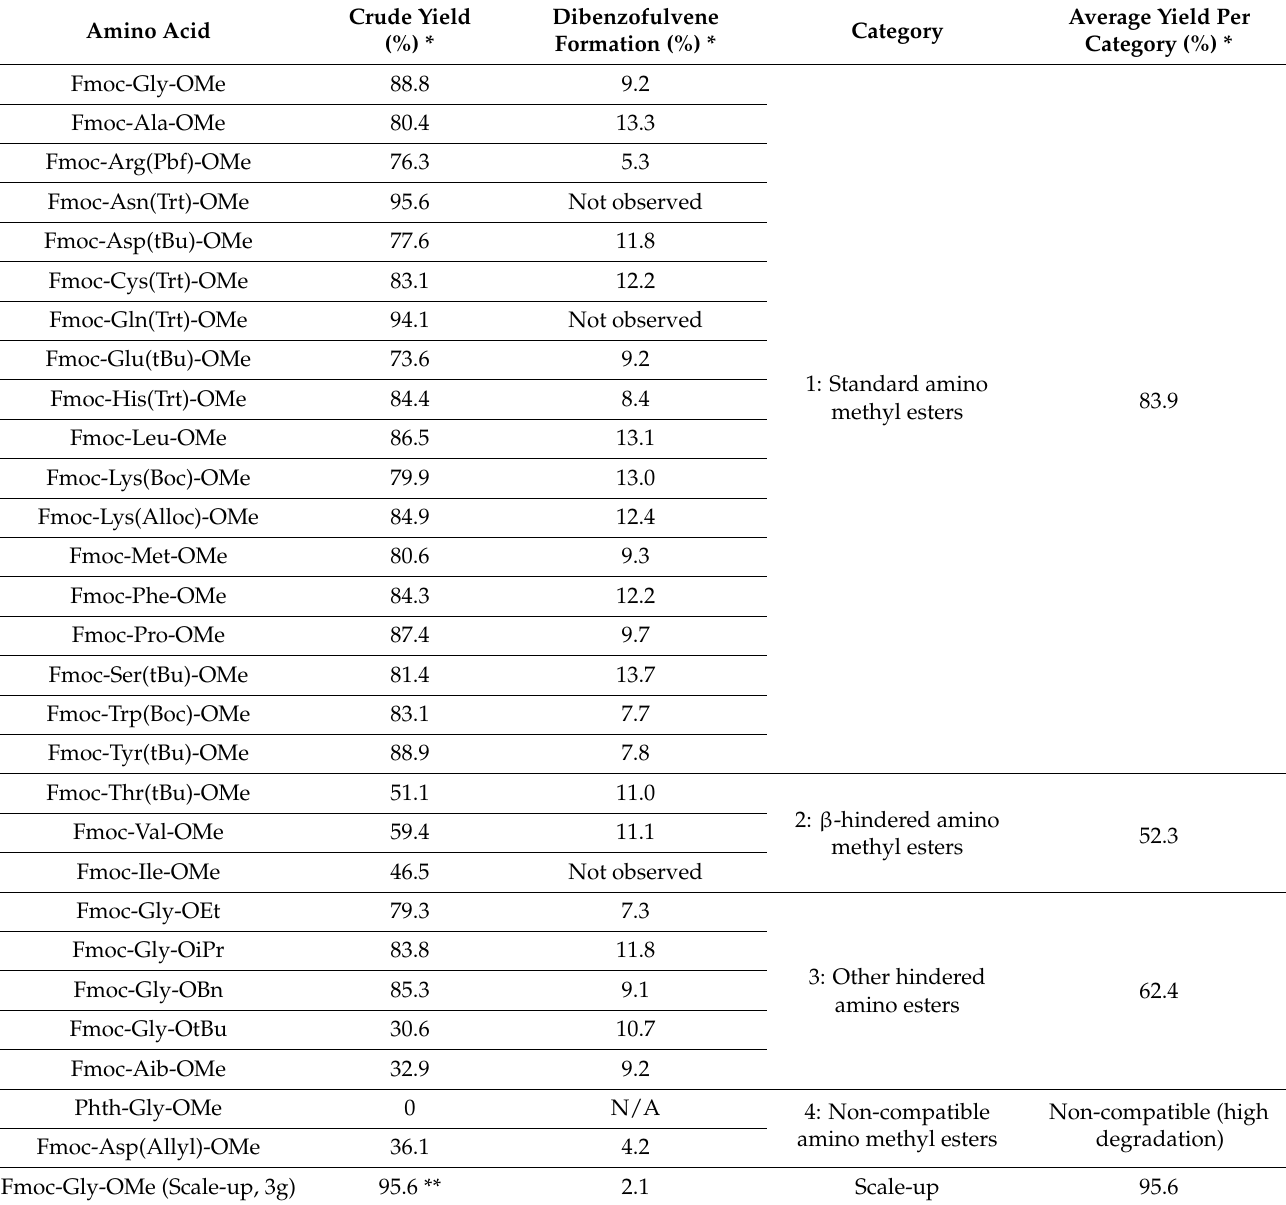
Table 2. Determination of the percentage of hydrolyzed product using UPLC-MS after 24 h of reaction